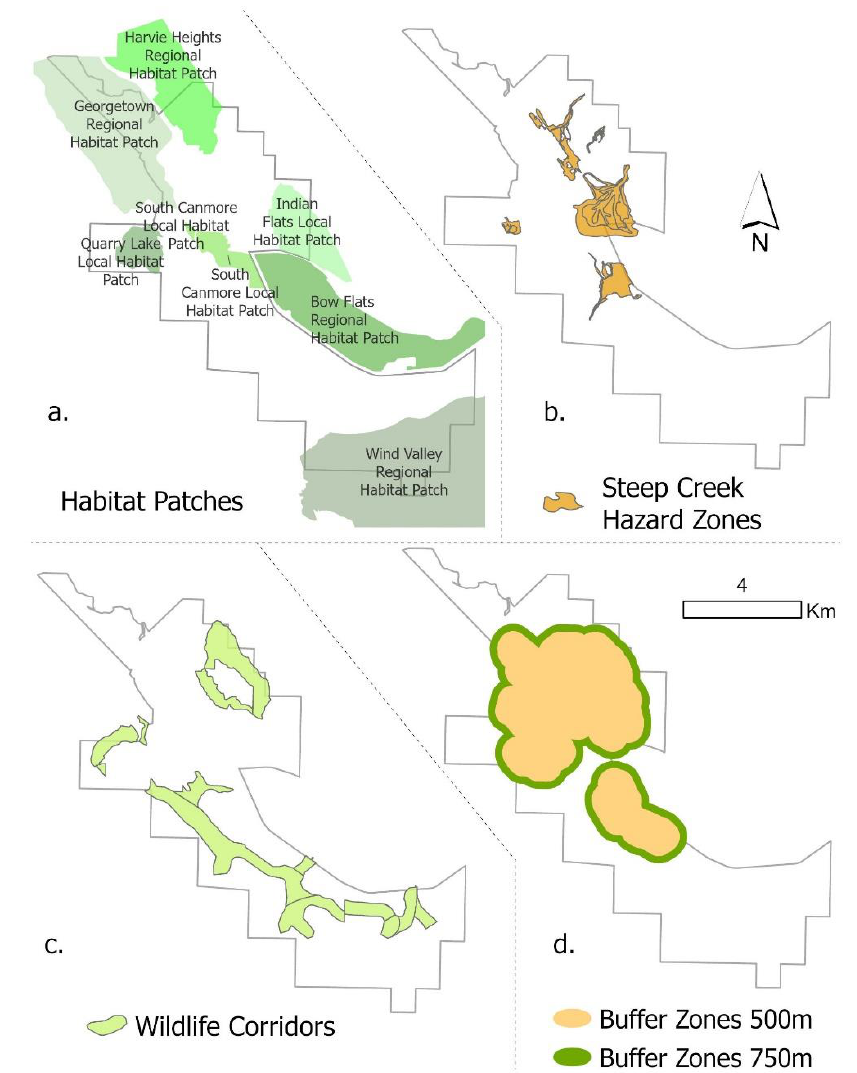
Figure 3. Four criteria are added to corresponding legally-accessible layers as scenarios including ( a ) regional habitat patches, ( b ) steep creek hazard zones that are subject to mass wasting, ( c ) the wildlife corridors and ( d ) two setback buffer zones of 500 and 750m, respectively, away from residential zones in Canmore.